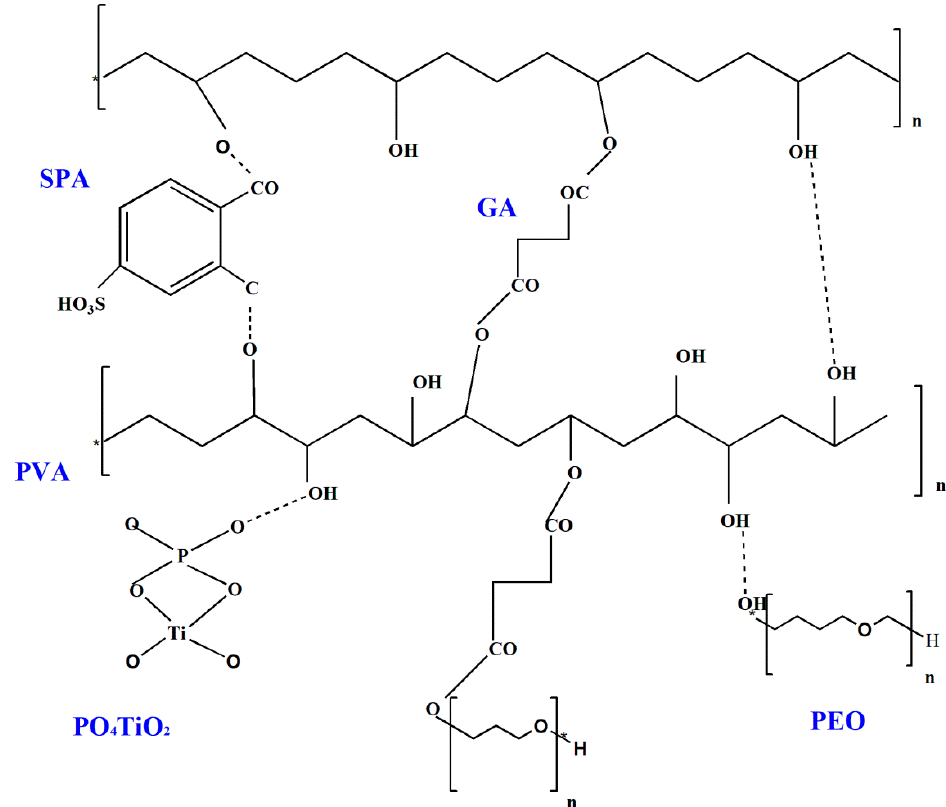
Figure 1. Probable structure of the SPVA/ PEO/ PO 4 TiO 2 membrane.